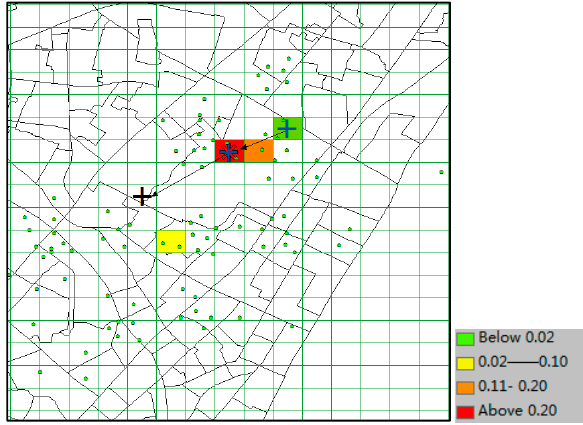
Figure 19. Result of Markov.